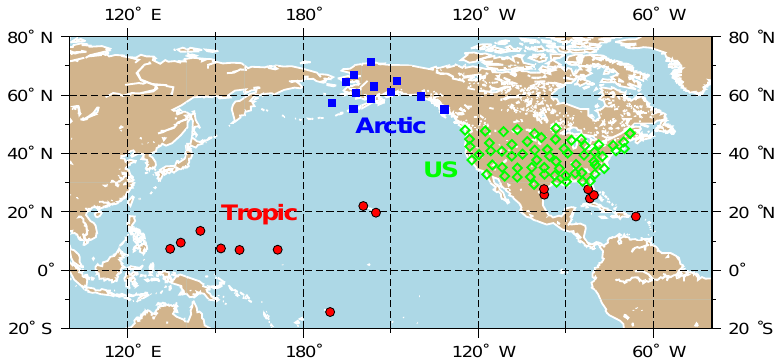
Figure 11. Location of US-owned HVRRD stations used in this study. The stations are classified into three latitudinal regions: the tropics (15 sites, red filled circles), US (64, green open diamonds), and Arctic (Alaska; 13, blue filled squares).